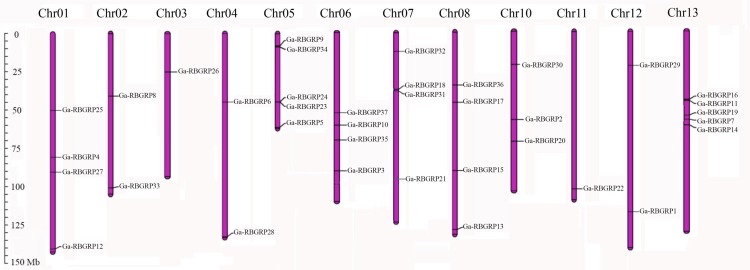
Chromosomal localization of RB-GRP genes in G.arboreum.The scale on the left was in megabases (Mb).